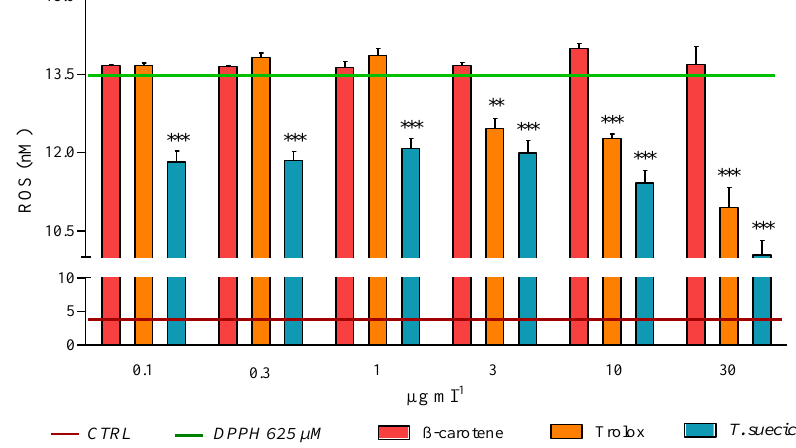
Figure 8. ROS concentrations in PNT2 cells pre-treated with β-carotene, Trolox and T. suecica extract (at 0.1, 0.3, 1, 3, 10 and 30 µg mL −1 ) and then injured with 625 µM of DPPH. After 6 h of treatment, the resulting cell lysate was analysed with a plate reader (Ex: 480 nm, Em: 530 nm). The green bar (at 13.58 nM) represents ROS levels in PNT2 cells treated only with DPPH (DPPH 625 µM); the red bar (4.06 nM) represents ROS levels in untreated cells (control, CTRL). The values reported are the mean ± SD of three independent experiments. Asterisks indicate statistically significant differences compared to positive control (** p < 0.01, *** p ≤ 0.001; Dunnett’s test).